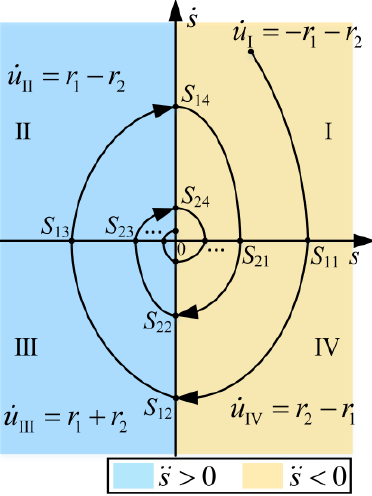
Figure 2. Convergence trajectory of the converter system under the twisting controller. Based on the stability theory of HOSM [38], if the converter system is stable with 2-SM, the second-order derivative of the sliding variable in (9) needs to be bounded. From (5), since the matrices β 1 , β 2 , β 3 and β 4 were bounded and the duty ratio u ∈ [0, 1], there was a constant H , satisfied with From (9), the system stability was equivalent to the existence of the following condition.